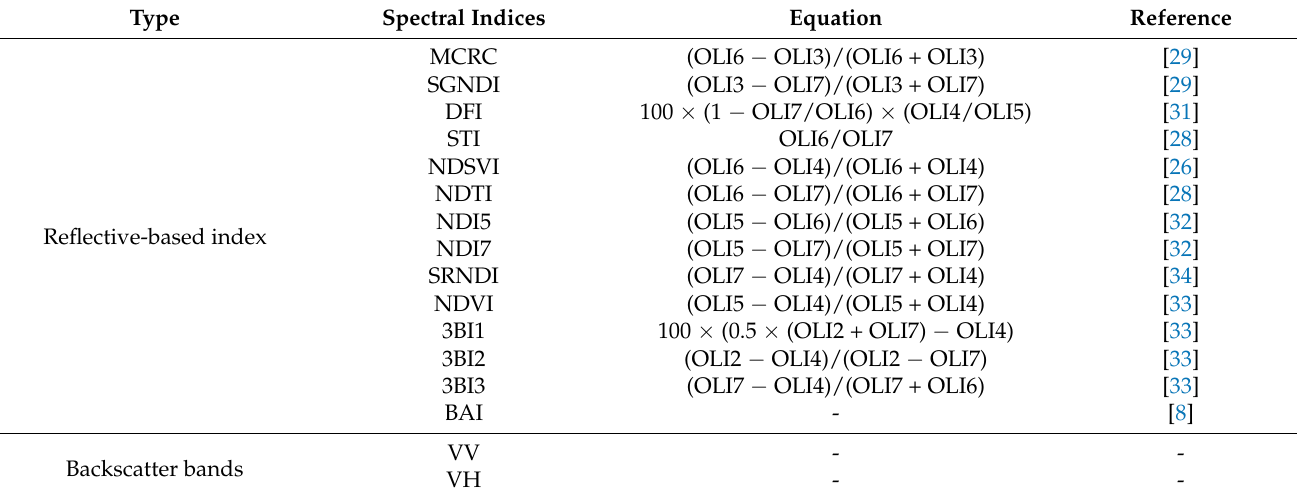
Table 1. Spectral indices and radar bands used as independent and primary variables in RCF